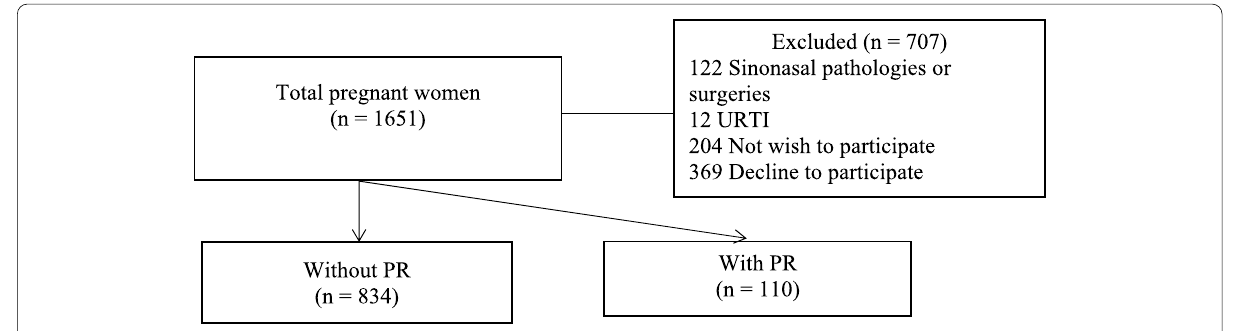
Fig. 1 Flow chart of the studied patients